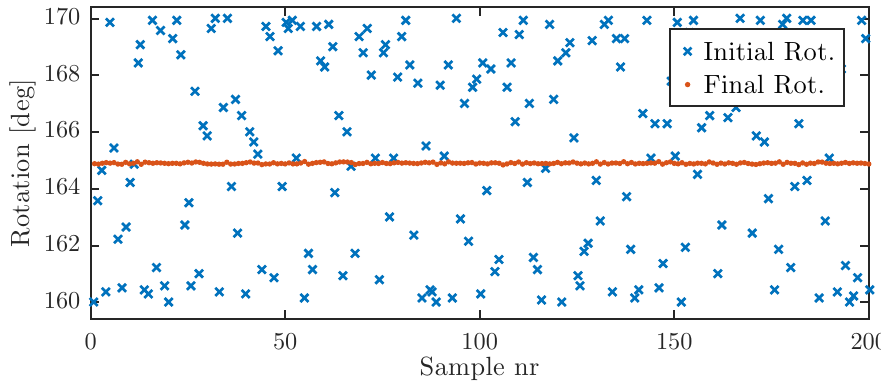
Figure 12. Initial and final rotation of the pipe for 200 calibration cycles for the 165 ◦ case. Each cycle was seeded with a random angular error, distributed around the target